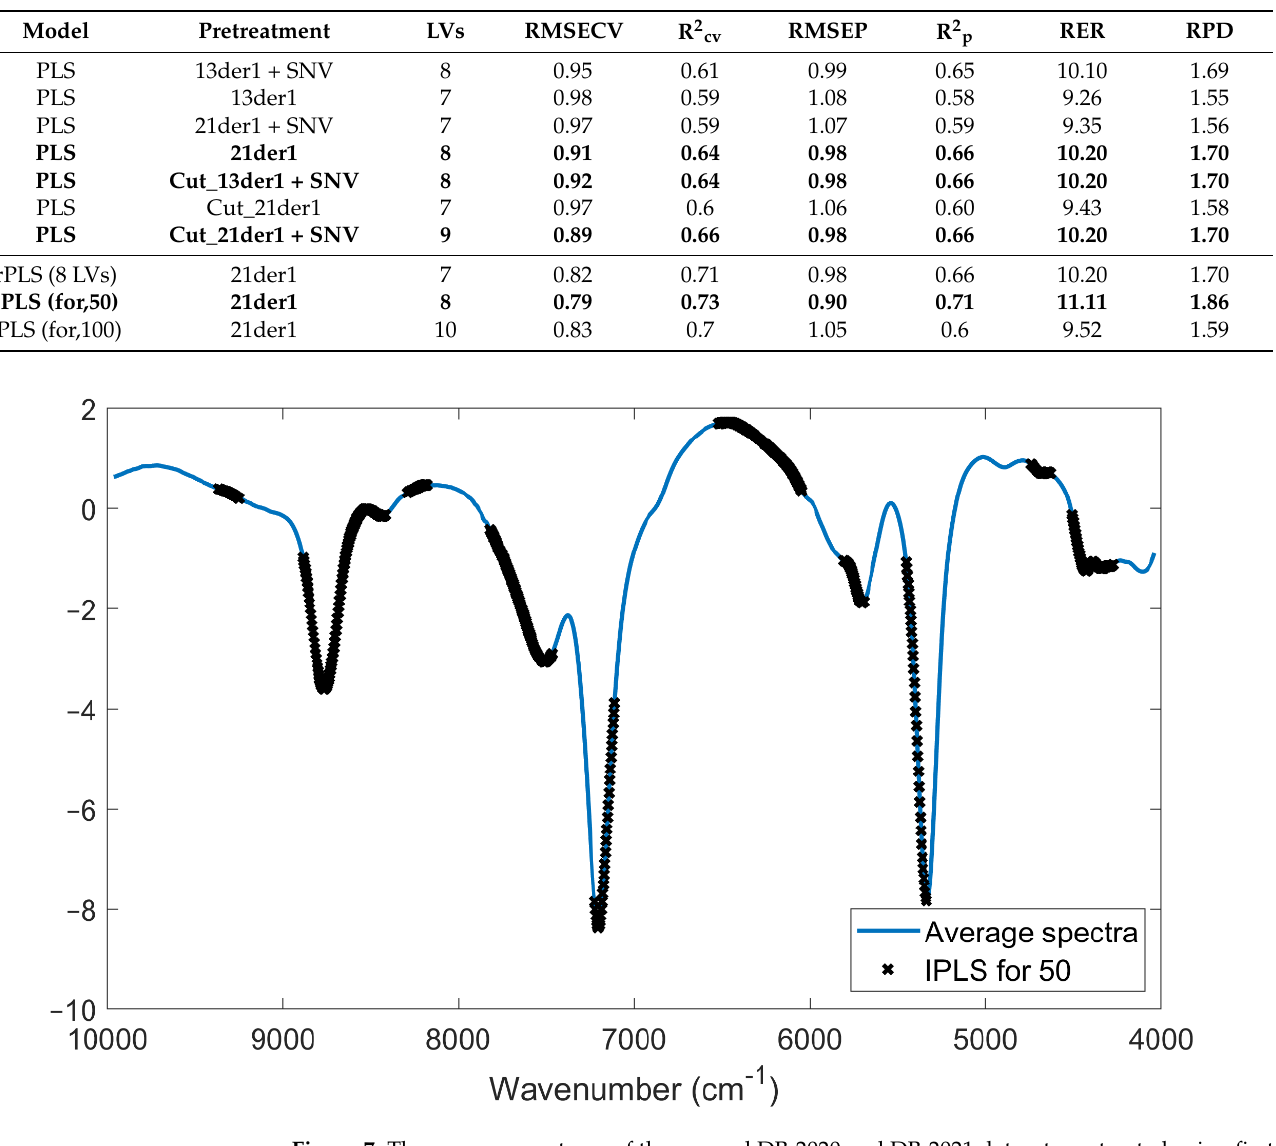
Table 4. Summary of partial least squares regression (PLS) results and summary of PLS results applying variables selection techniques to the merged DB-2020 and DB-2021 datasets for SSC ( ◦ Brix) prediction models. The best PLS models are marked in bold (xder1 = first derivative with x number of smoothing points; SNV = standard normal variate; LVs = latent variables; RMSECV = root mean